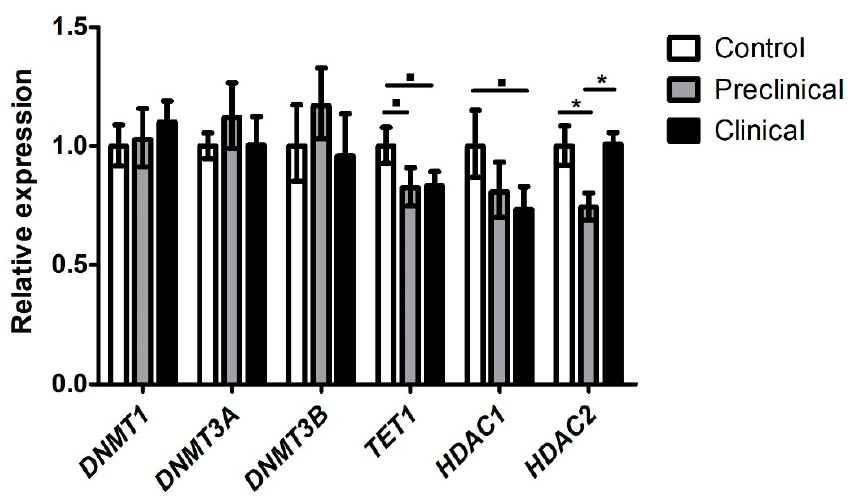
Figure 3. Relative expression levels in terms of 2 − ∆∆ Ct of genes involved in epigenetic regulation in the thalamus of sheep. ▪ p = 0.1; * p < 0.05.